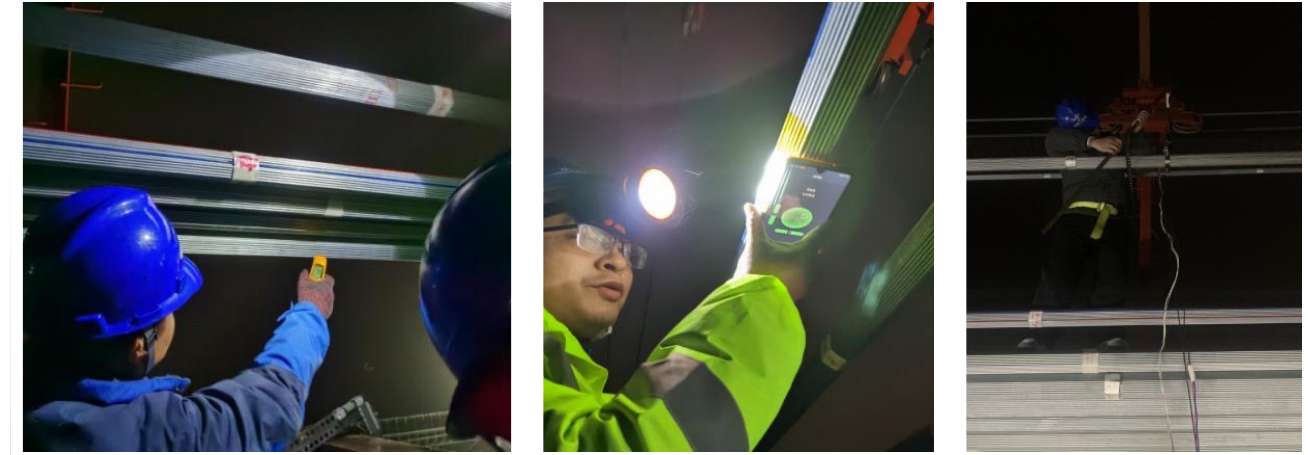
Figure 20. Photos of cable strand temperature, angle, and height difference measurement. Table 6. Measurement results of the caliper vs. the proposed measuring system.